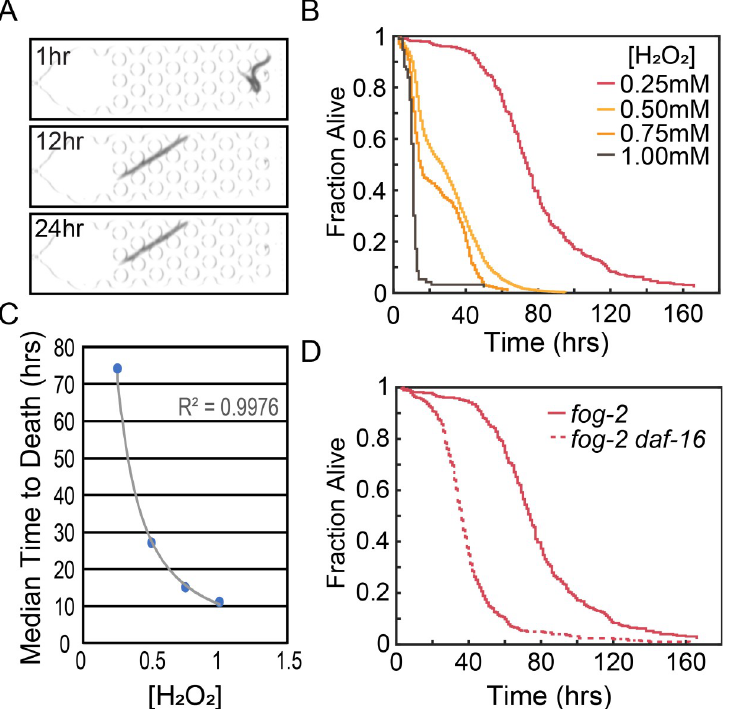
Fig 5. Oxidative stress. (A) Images of a representative fog-2 ( q71 ) animal at 1, 12, and 24hrs showing the characteristic rod-like death. (B) Lifespan curves for fog-2 ( q71 ) animals in M9 buffer supplemented with increasing concentrations of H 2 O 2 (Number of animals = 379 (0.25 mM), 3518 (0.5 mM), 276 (0.75 mM), 93 (1 mM)). (C) Power fit of median lifespan versus concentration of H 2 O 2 yields an equation (y = 10.503x -1.394 ) with an R 2 of 0.9976. (D) Comparison of fog-2 ( q71 ) and fog-2 ( q71 ) daf-16(mgDf47) animals at 0.25 mM H 2 O 2 (Number of fog-2 daf-16(mgDf47) animals is 498). Log-Rank p < 0 . 0001 .